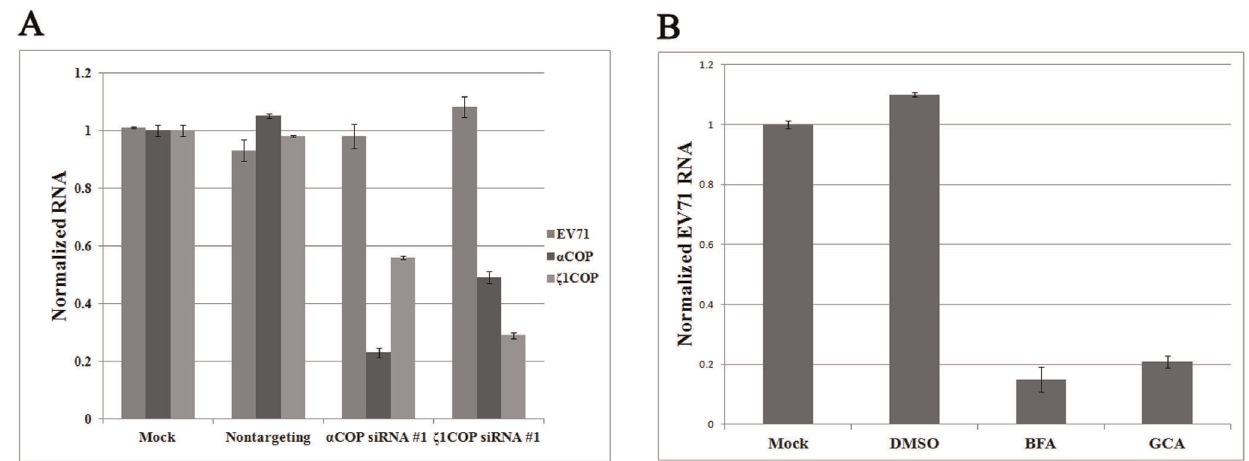
Figure 5. COPI is required downstream of viral entry. ( A ) Cells were pretreated with siRNA, infected at 4 u C to allow surface binding, followed by 3 hr at 25 u C to resume endocytosis. Viral entry was measured by determining viral genome copies, which was almost unchanged between COPI knocked down group and control group ( P . 0.05). ( B ) BFA and GCA inhibited EV71 replication ( P , 0.05), when added up to 6 hpi. RD cells were infected with at 0.1 MOI and harvested at 24 hpi. The experiment was performed in triplicate, and the bars represent means 6 SD.